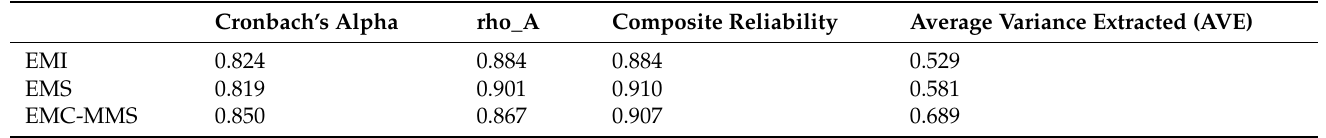
Table 4. Construct validity and